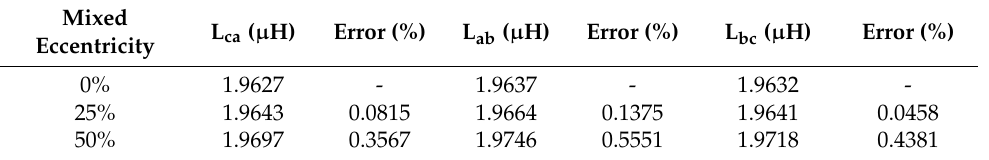
Table 5. Line-to-line inductance (absolute value) according to mixed eccentricity.